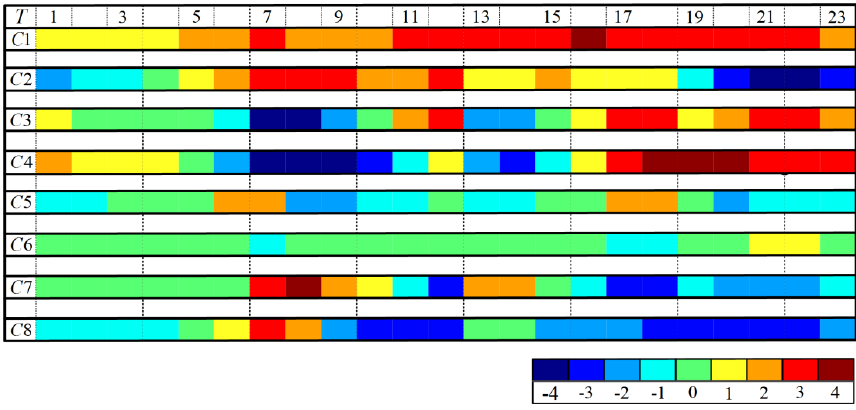
Figure 6. Clustering patterns of human convergence and divergence.